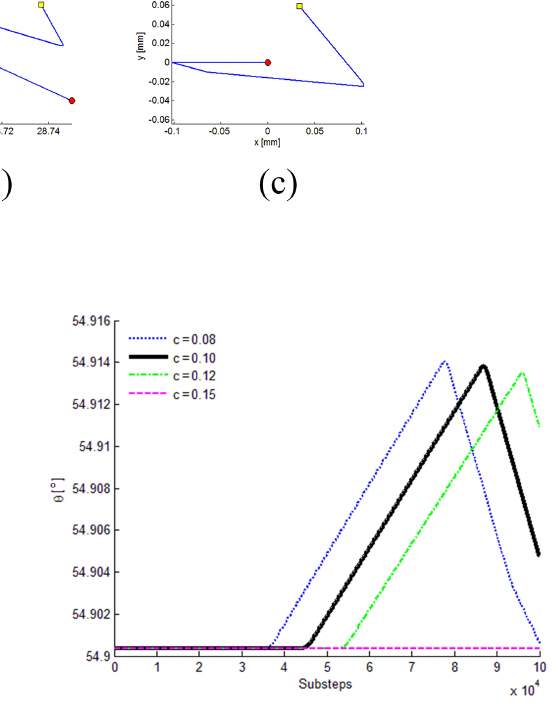
Figure 14. Deflection angle of AB under different clearance sizes.